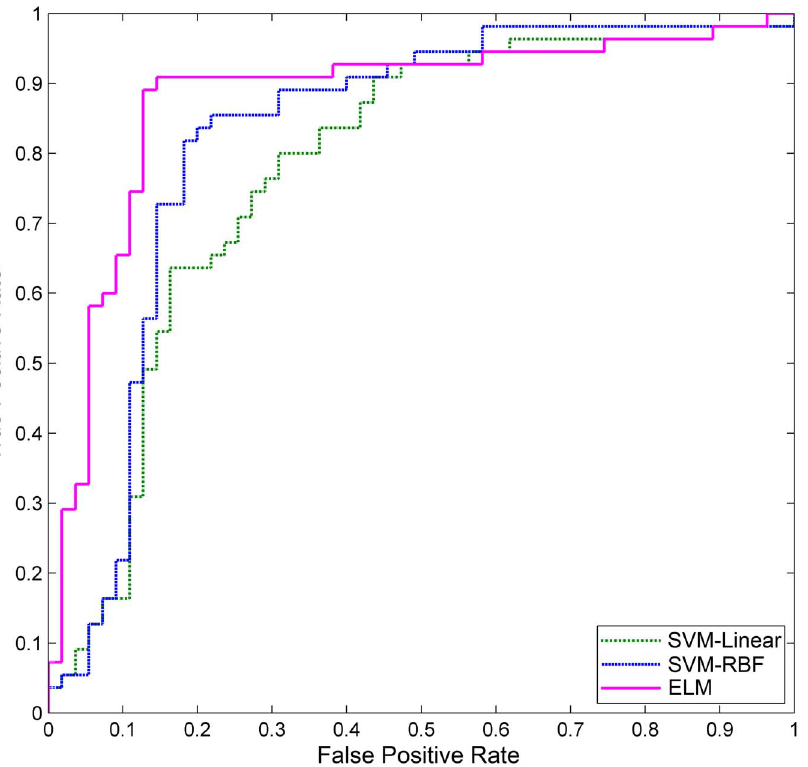
Figure 5. The receiver operating characteristics (ROC) curve for three classifiers discriminating between ADHD patients and healthy controls.